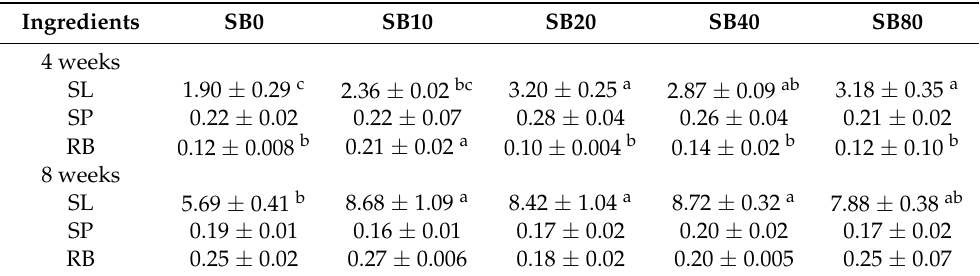
Table 5. Serum immunity of O. niloticus after four and eight weeks’ feeding with experimental